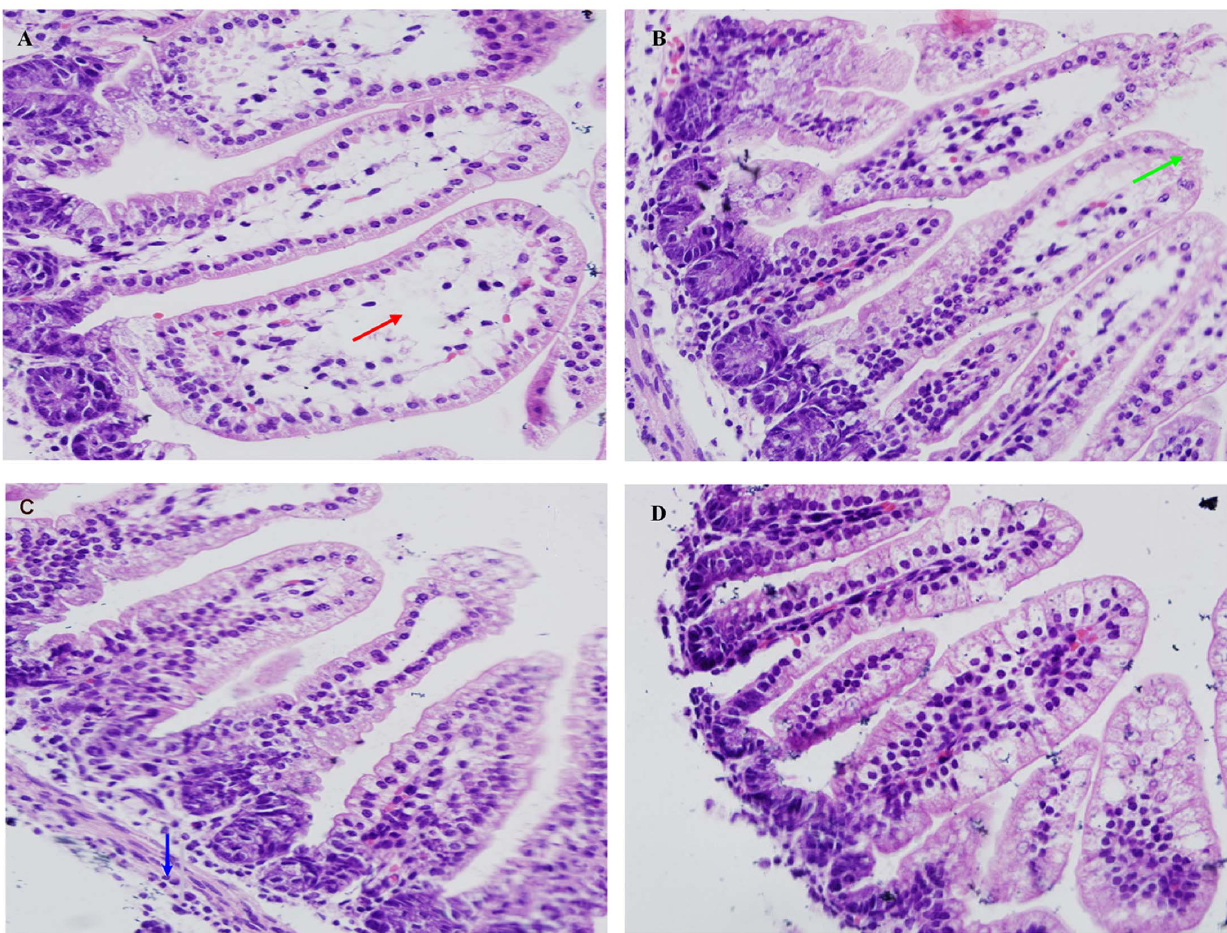
Figure 6. Jejunum changes as assessed by histology using a light microscope. (A) RV + PBS group. (B) RV + Ribavirin group. (C) RV + CsA group. (D) PBS group. (A-D) Morphologic changes in mouse jejunum pathology under a light microscope after 3 days of treatment (H&E, magnification: 200 6 ). Red arrow: Villus vacuolar degeneration. Green arrow: Lesion on the epithelium. Blue arrow: Intestinal hydropsia.